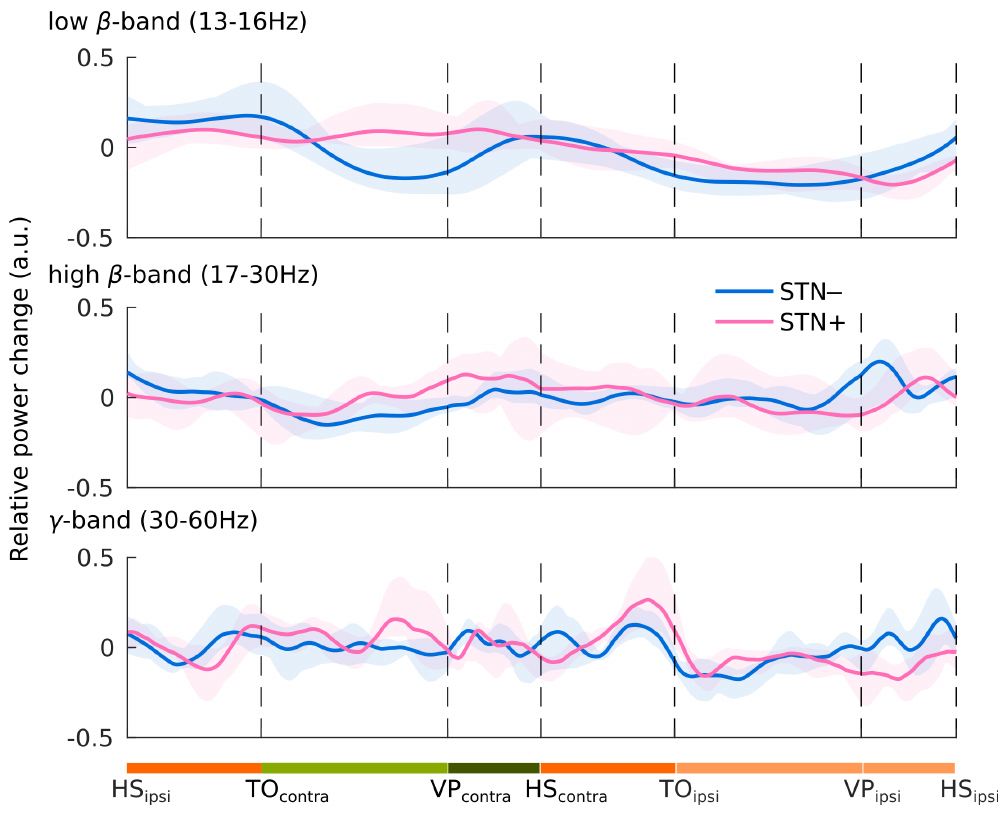
Fig 2. Modulation of the spectral power during the gait cycle. Event related synchronization (ERS) and desynchronization (ERD) in low β - (top) high β - (middle) and γ -frequency band (bottom). Subthalamic power changes of the phases of gait are shown as the average relative change of the whole stride of all subjects. Shaded areas represent the confidence intervals (5– 95%) of the group mean. We analyzed the power changes of STN–and STN+ during the gait cycle of the contralateral foot (but they could be also referred to the matched gait phases of the ipsilateral one). Stance is the period during which the foot is on the ground (dark and light orange bars). The stance phase includes a period of bilateral foot contact with the floor (double-support phases [dark orange bars]), and a period of unilateral foot contact (single-support phase [light orange bar]). The swing phase (light green and dark green bars) is the interval in which the foot is lifted from the floor. Thanks to the velocity peak (VP) of the marker placed on the lateral malleolus, we identified an acceleration (light green) a deceleration (dark green) sub-phase of the swing phase. HS = heel strike; TO = toe off; VP = velocity peak; lower case subscript indicates the foot contralateral (contra) or ipsilateral (ipsi) to STN–or